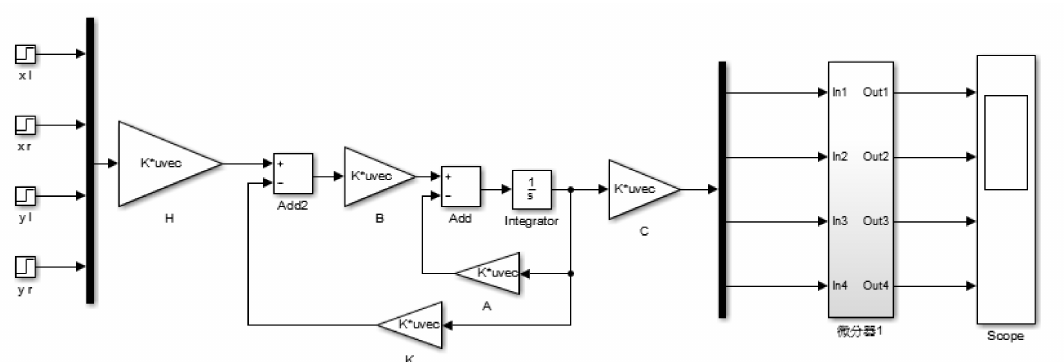
Figure 10. Simulink block diagram.